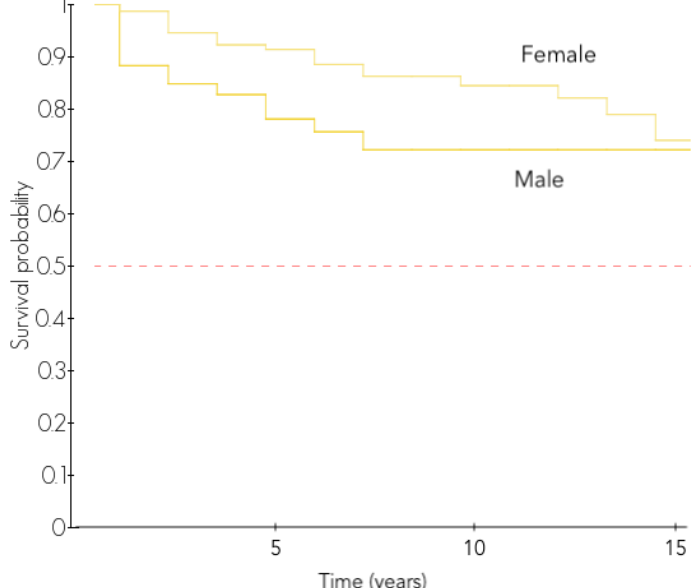
Figure 2. Revision-free survival according to the gender. However, after stratification over the etiology, this difference was found only in the revision RSA group (72.3% vs. 84.5% at 10 years, p = 0.020, Figure 3), and was not found in any other etiology.